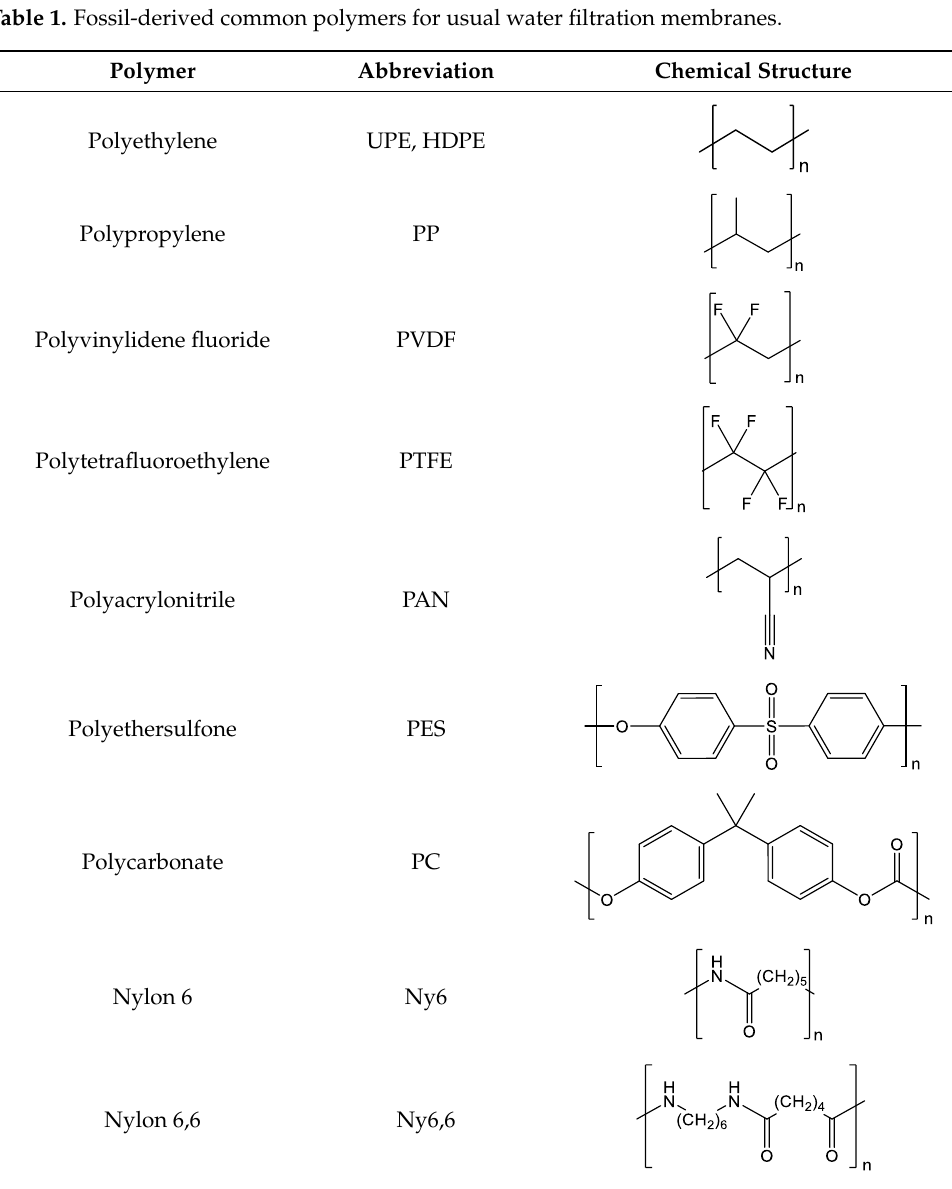
Table 1. Fossil-derived common polymers for usual water filtration